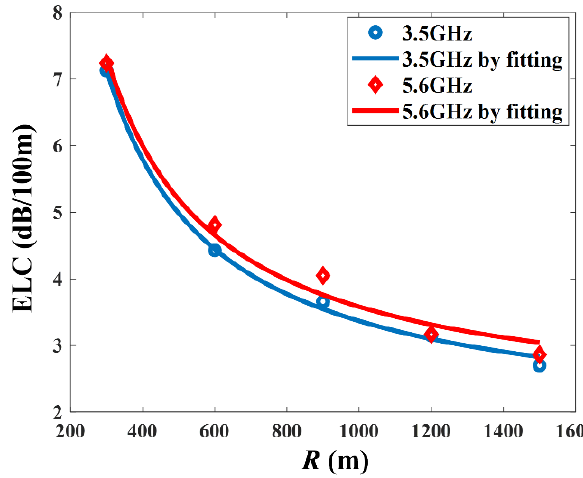
Figure 12. The relationship between ELC and R at 3.5 GHz and 5.6 GHz.